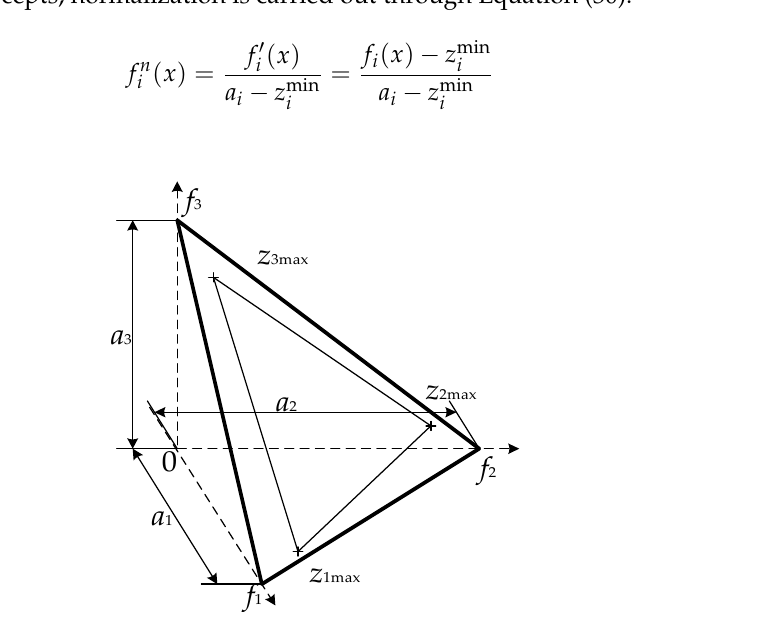
Figure 4. Computing intercepts and forming the hyperplane from extreme points.